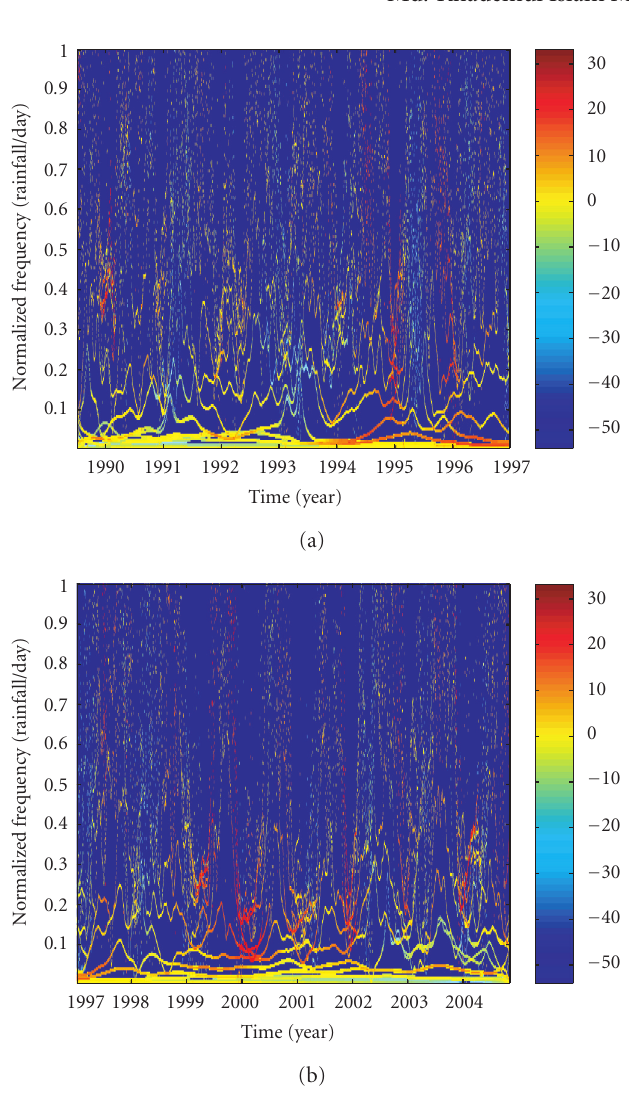
Figure 3.4. (a) Hilbert spectrum with 3 × 3 Gaussian filtering of a part of the rainfall data (1989 to 1997 for better visualization) using 256 frequency bins. The amplitude is in dB. (b) Hilbert spectrum with 3 × 3 Gaussian filtering of a part of the rainfall data (1997 to 2004 for better visualization) using 256 frequency bins. The amplitude is in